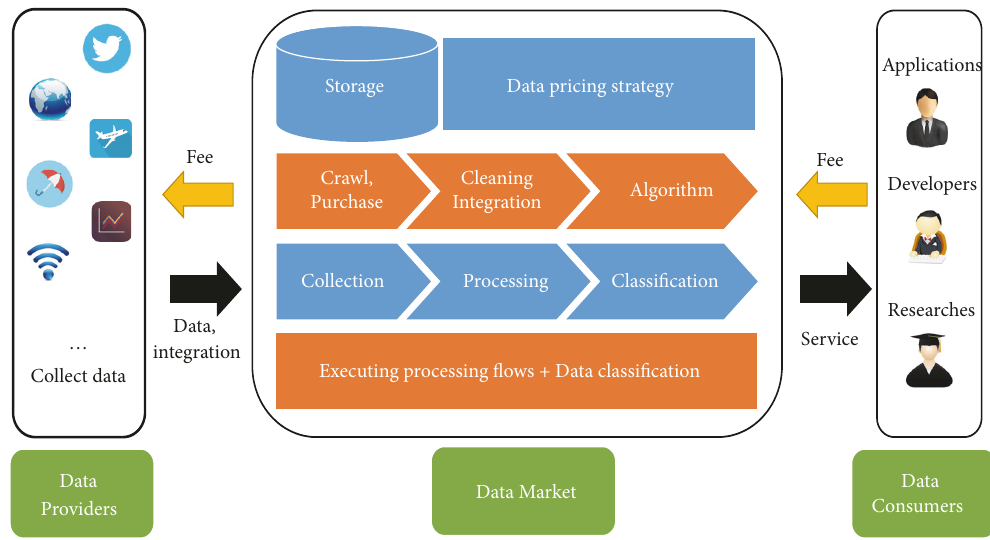
Figure 1: A typical big data market